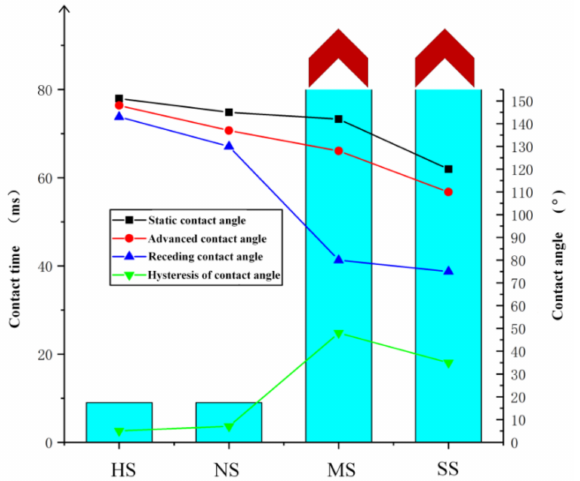
Figure 9. Relationship between contact angle and impact contact time of